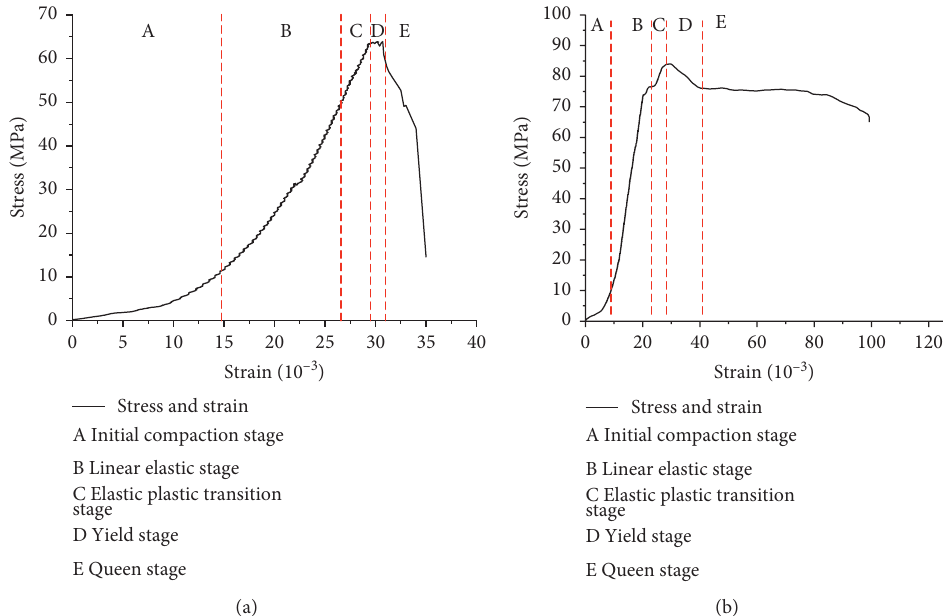
Figure 9: Stress–strain curves of sandstone samples. (a) uniaxial stress–strain curves and (b) stress–strain curves of samples with holes plus confining pressure.